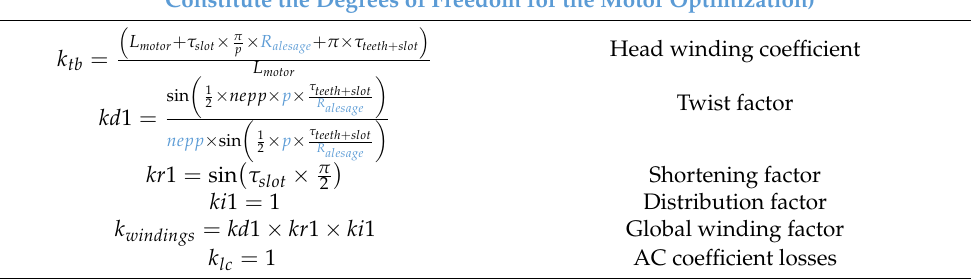
Figure 6. Electric circuit model of the permanent magnet synchronous machine. Table 6. Winding configuration computation process. Electric Motor Winding Configuration (in is Blue the Set of Decision Variables which Constitute the Degrees of Freedom for the Motor Optimization)